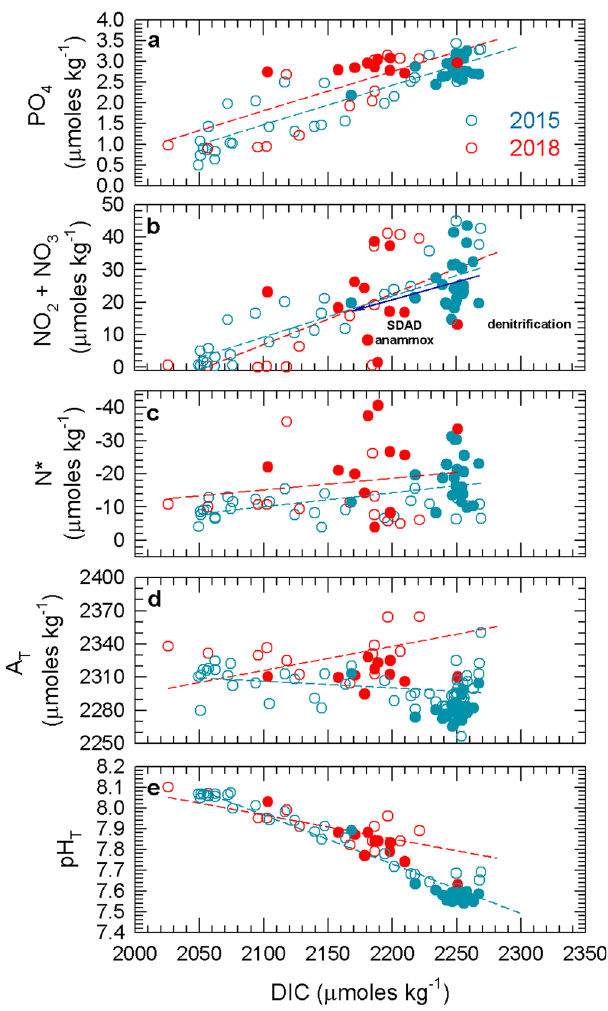
Fig. 4 Relationship between dissolved inorganic carbon (DIC) versus nutrients and other carbonate chemistry parameters. ( a ) PO 4 3 − , ( b ) inorganic nitrogen (NO 2 − + NO 3 − ), ( c ) N*, ( d ) total pH (pH T ), and ( e ) total alkalinity (A T ), within the range from surface to 1000 m water depth during 2015 and 2018 expeditions. Filled symbols correspond to data points associated with O 2 concentrations < 20 μ mol kg − 1 . The correlations observed in low oxygen waters ( fi lled points) for DIC versus nitrogen at 2015 is given and indicated by the dark blue line ( b ). Labels in ( b ) were included to emphasize the processes highlighted in the stoichiometric analysis (e.g. Annamox, sulfur-driven autotrophic denitri fi cation (SDAD), and denitri fi cation).